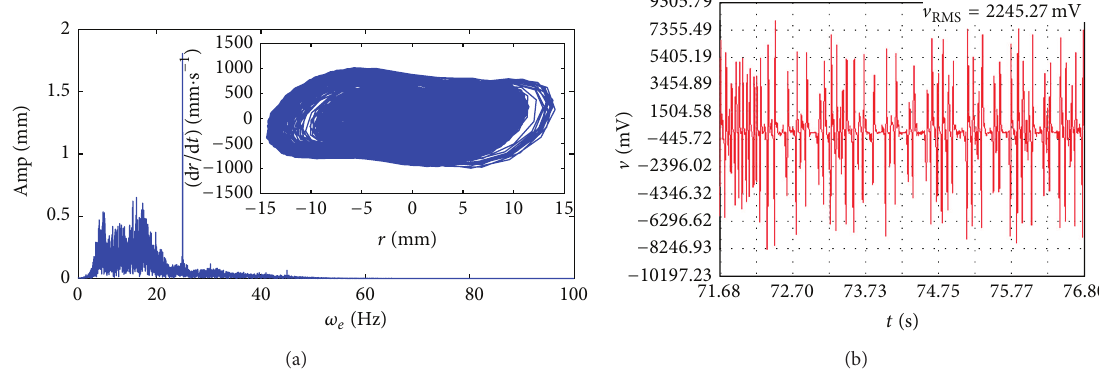
Figure 17: Experimentally obtained chaotic response for 𝑍 𝑒 = 2.5𝑔 and 𝜔 𝑒 = 25 Hz: (a) phase plot and frequency spectrum and (b) time series of output voltage.